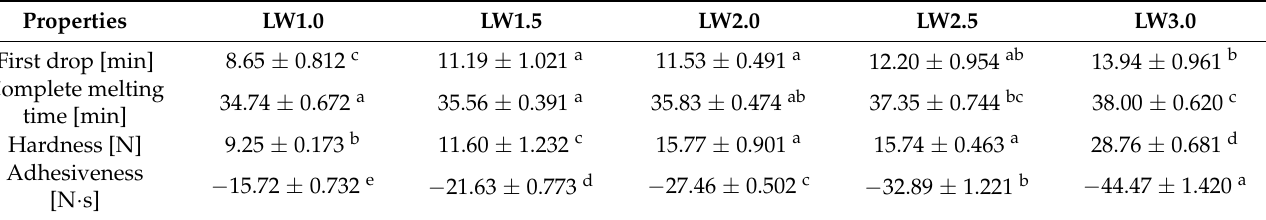
Table 5. Physical properties of the tested